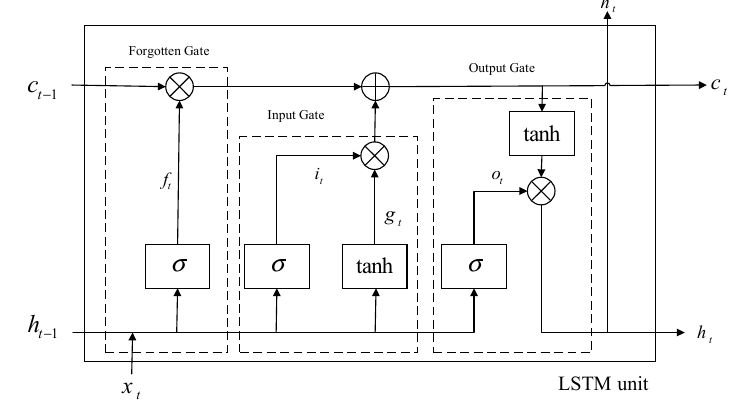
Figure 5. Basic structure of LSTM.